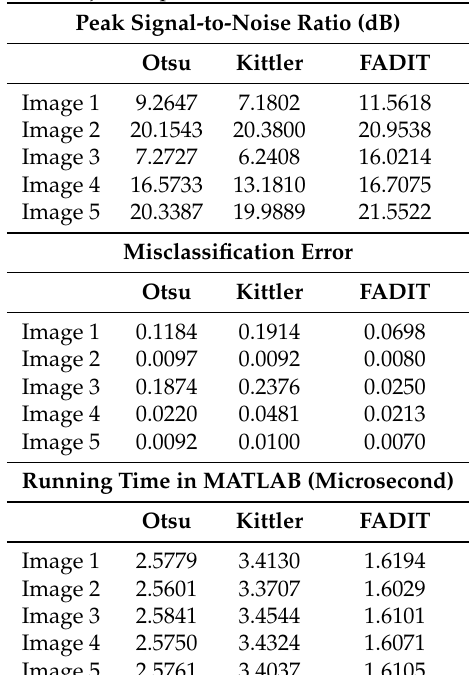
Table 2. Objective performance of different